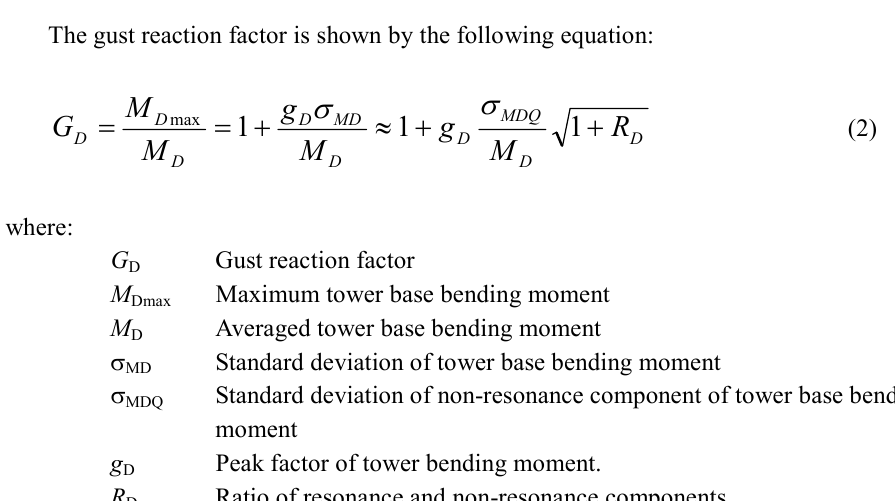
Fig. 6 Time series data of wind turbine operation ( U ave